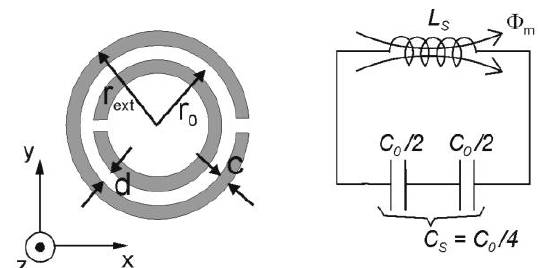
Figure 3. SRR topology and its equivalent circuit